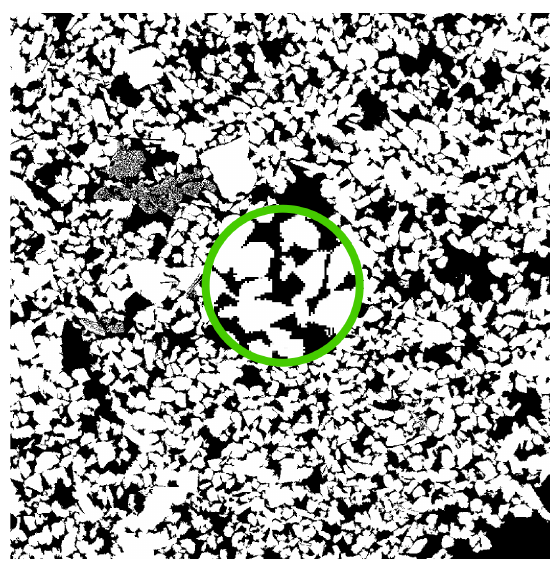
Figure 6. Output from segmentation procedure show- ing image suitable for structural analysis with high- lighted detail of microstructure.